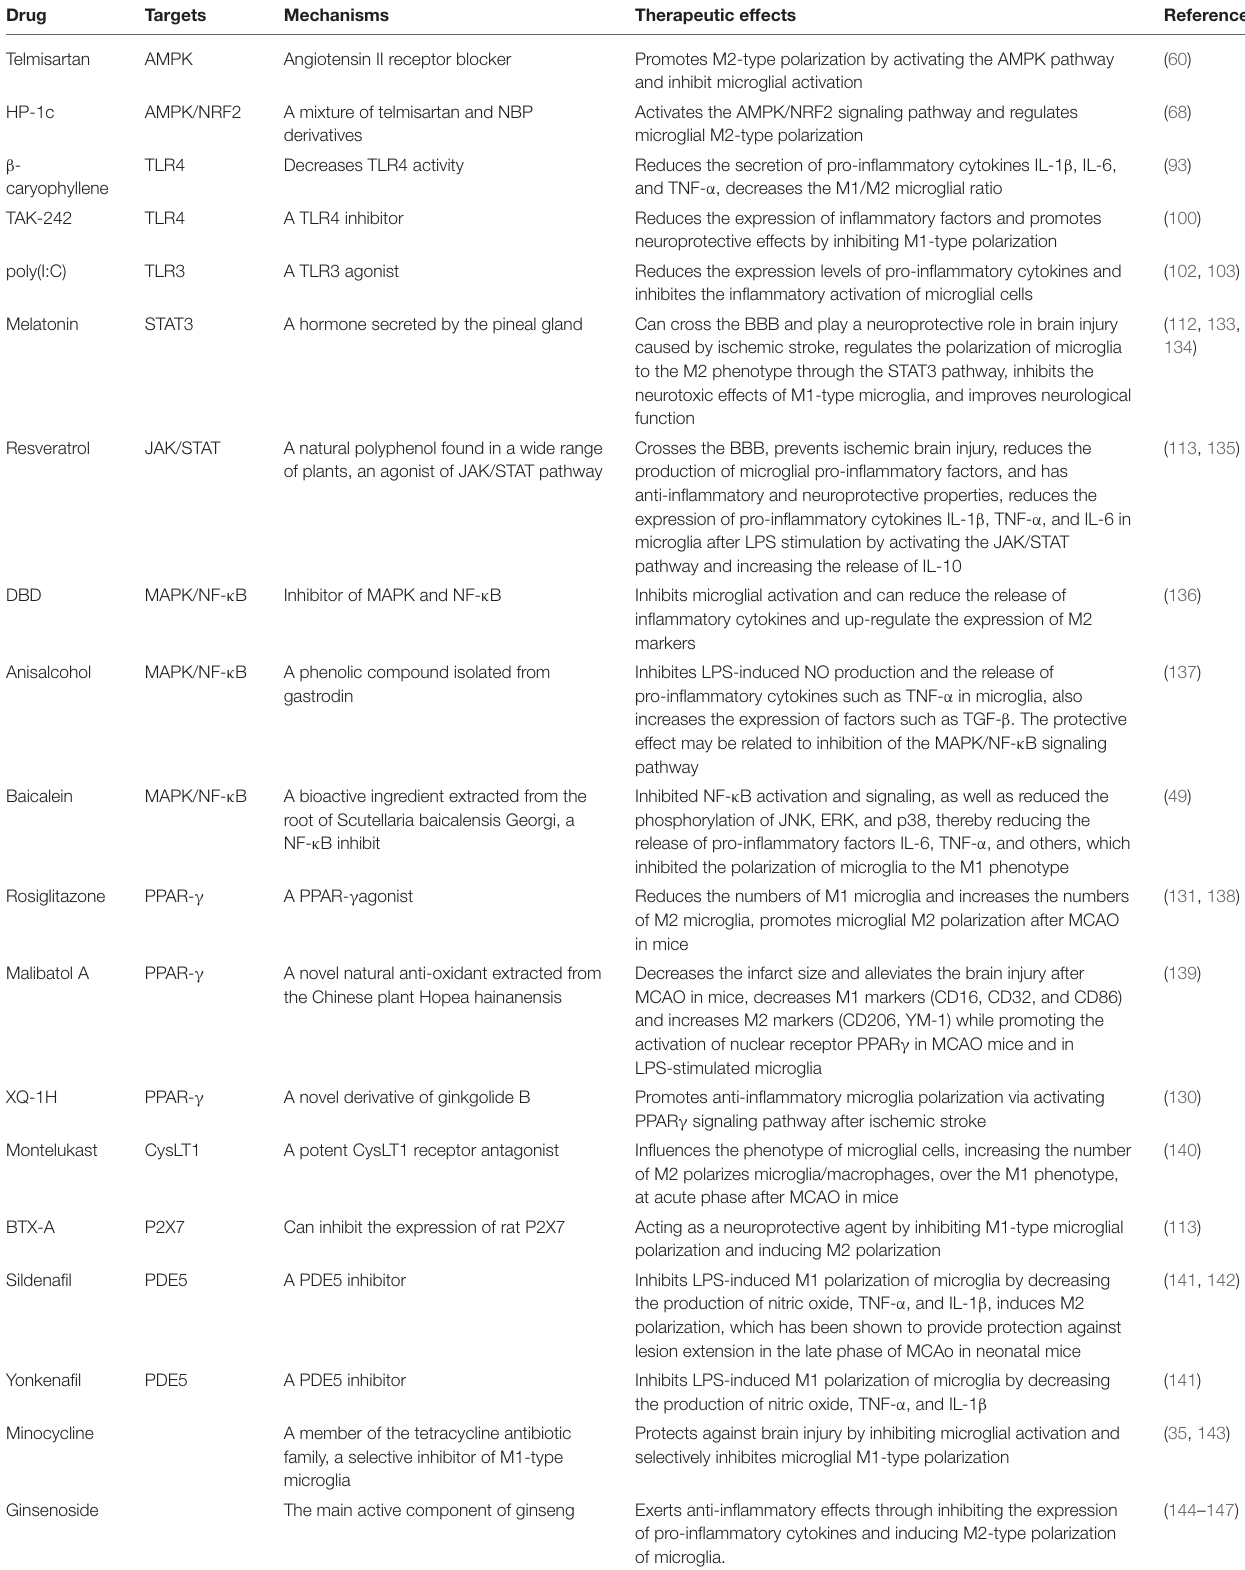
TABLE 1 | Drug factors affecting microglial activation and